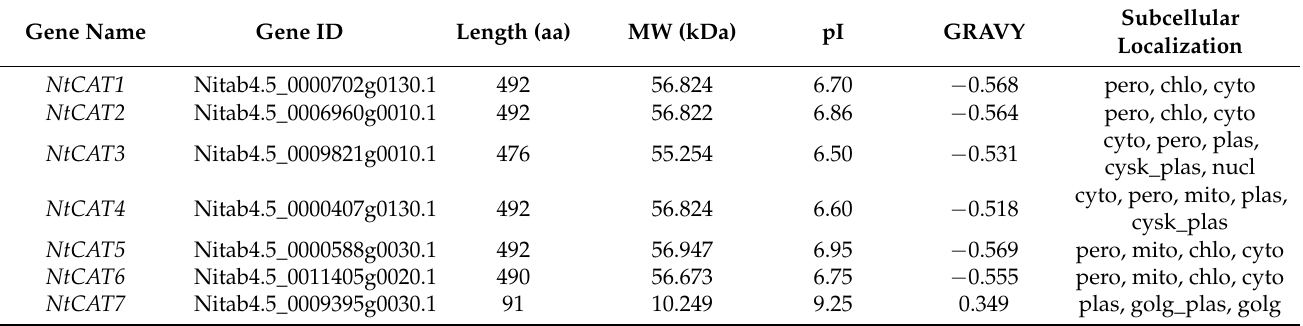
Table 1. The members of CAT gene family in Nicotiana tabacum